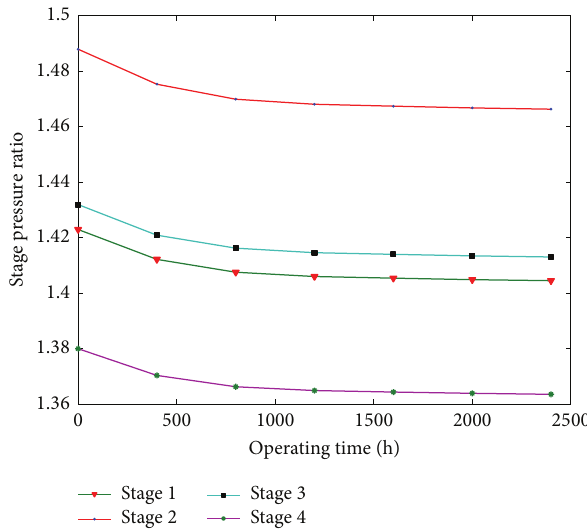
Figure 7: The relation between stage pressure ratio and operating time for fouled stages.